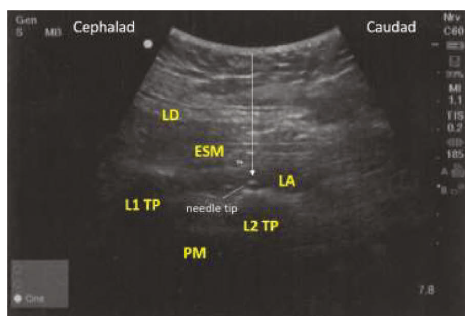
Figure 1: Ultrasound image of lumbar erector spinae plane block. LD � latissimus dorsi; ESM � erector spinae muscle; LA � local anesthetic; L 1 � lumbar transverse process; L 2 � lumbar transverse process; PM � psoas muscle. The white arrow indicates needle placement using an out-of-plane technique. The local anesthesia is injected just below the erector spinae muscle and above the transverse process of the targeted vertebral